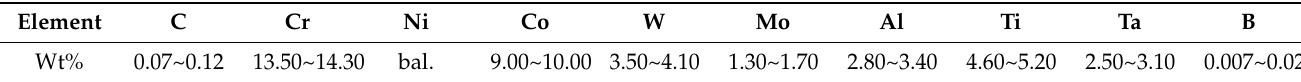
Table 1. The nominal composition of DSM11